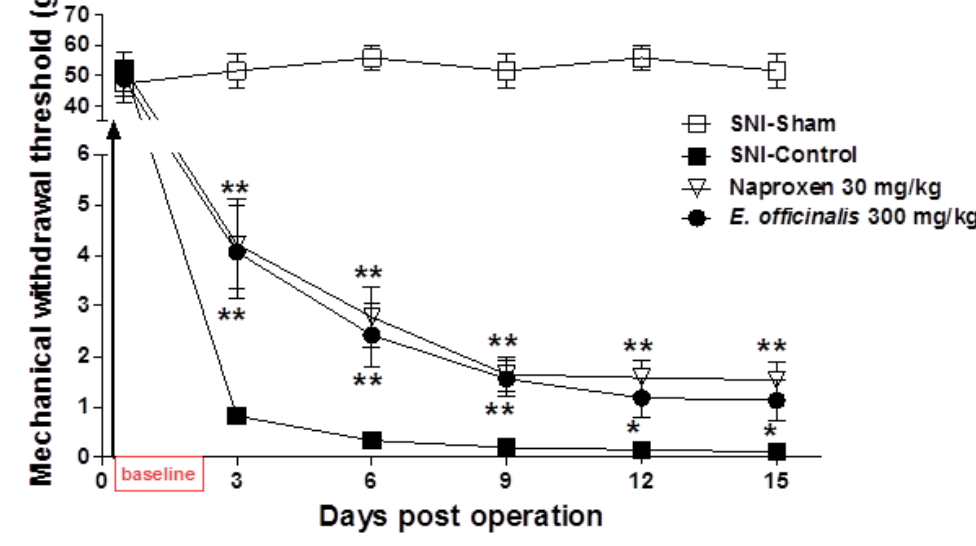
Figure 3. Effect of E. officinalis extracts on a spared nerve injury (SNI) rat model of neuropathic pain. Administration of E. officinalis extracts (300 mg/kg, oral administration (p.o.)) significantly attenuated hypersensitivity in response to von Frey stimulation of the hind paw, from 3 to 15 days after treatment. Data represent the mean ± SEM ( n = 9 per group). ** p < 0.01, and * p < 0.05 significant difference from the control group.